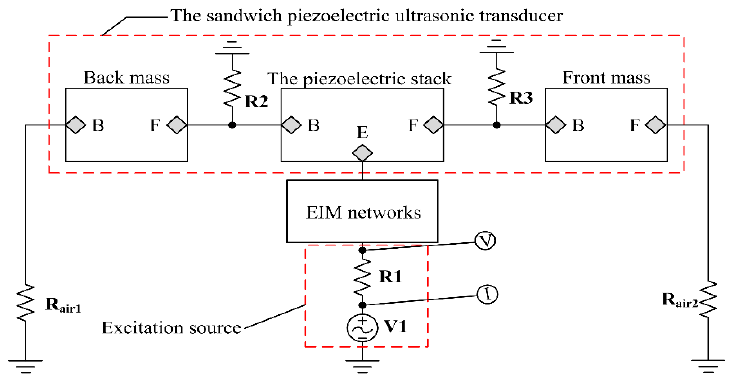
Figure 3. The PSpice model of single sandwiched piezoelectric ultrasonic transducer with EIM networks.